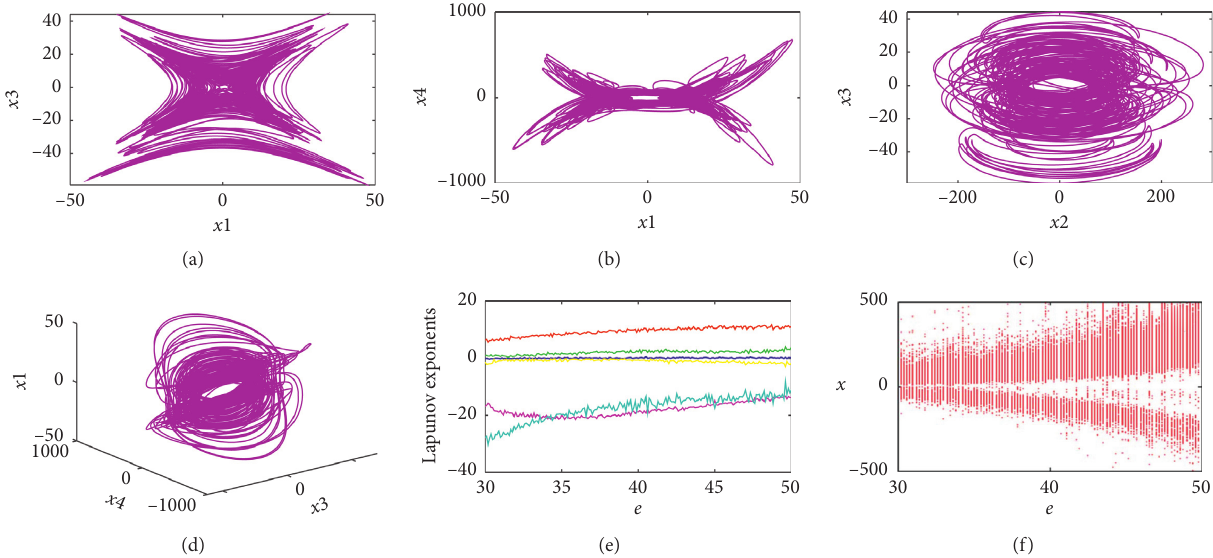
− z plane of 6D FWMHS attractors; (c) z 1 5